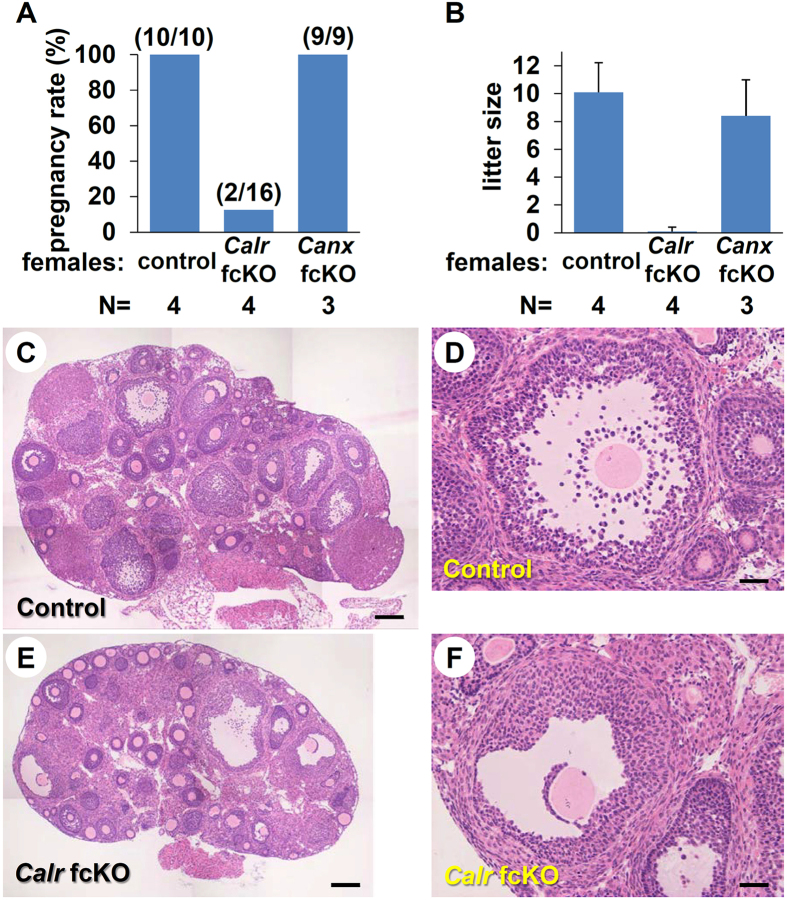
Abnormal ovarian follicular development in Calr fcKO mice.(A) Pregnancy rate (pregnancy/vaginal plug formation) obtained by mating control (Calrfl/+; Zp3-cre), Calr fcKO (Calrfl/−; Zp3-cre) and Canx fcKO (Canxfl/−; Zp3-cre) females with B6D2F1 wild-type male mice. The total number of plugs observed is indicated in parentheses. (B) Average litter sizes obtained by mating control, Calr fcKO and Canx fcKO females with B6D2F1 wild-type male mice. (C–F) Histological analysis of ovarian sections. Preovulatory follicles from Calr fcKO mice demonstrate immature follicles just under the surface of the ovary. The cumulus mass surrounding oocytes is composed of fewer cells than control. Scale bar = 300 μm (C,E) and 50 μm (D,F). Error bars represent standard deviation (B).